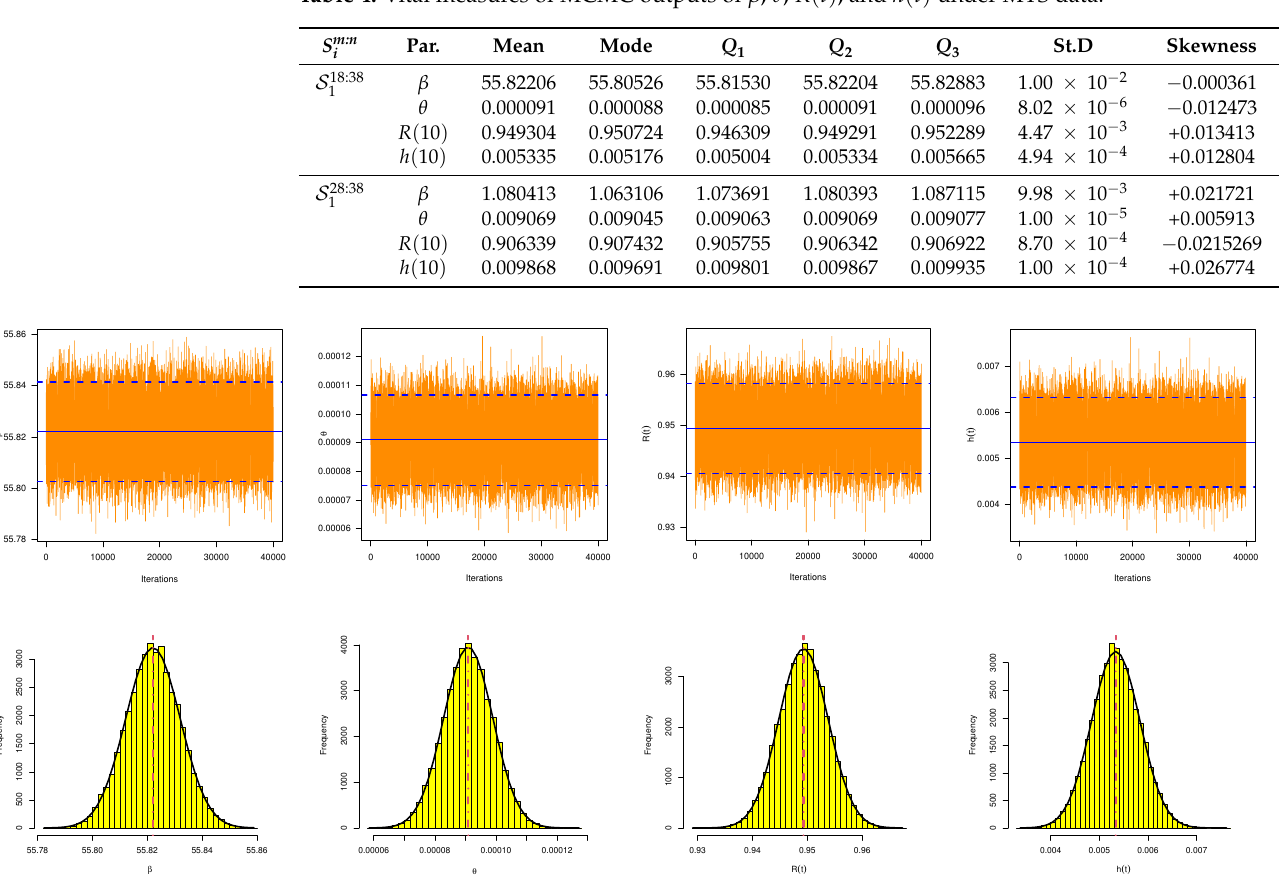
Table 4. Vital measures of MCMC outputs of β , θ , R ( t ) , and h ( t ) under MTS data.